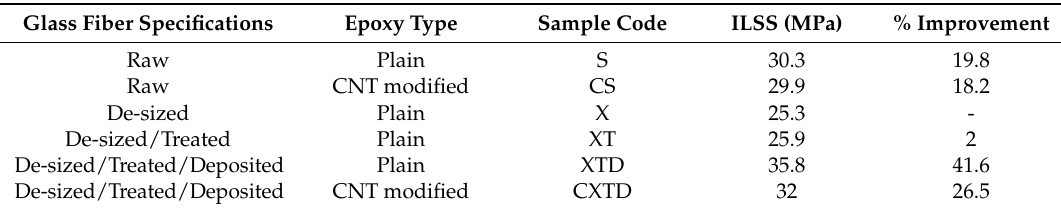
Table 2. Interlaminar shear strength (ILSS) of CNT-reinforced nanocomposites with different glass fiber treatment.